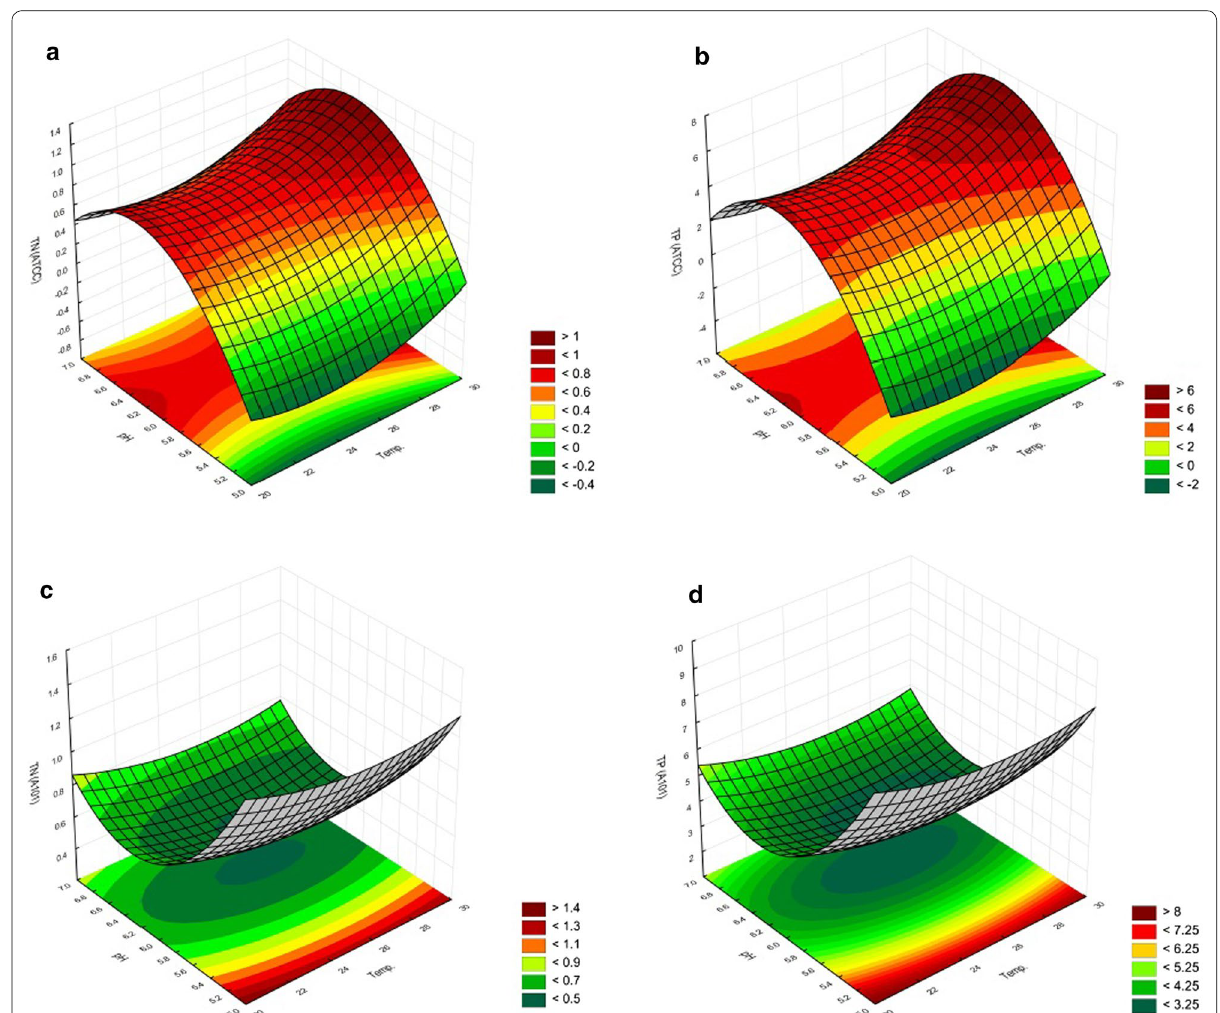
Fig. 2 Response surface plots showing individual and interaction effects of the following variables: temperature and pH on TN and TP levels for Y. lipolytica ATCC 9793 and Y. lipolytica A-101 strains cultured on biofuel waste (the SK medium). a TN ( Y. lipolytica ATCC 9793), b TP ( Y. lipolytica ATCC 9793), c TN ( Y. lipolytica A-101), d TP ( Y. lipolytica A-101). TN, total nitrogen; TP, total